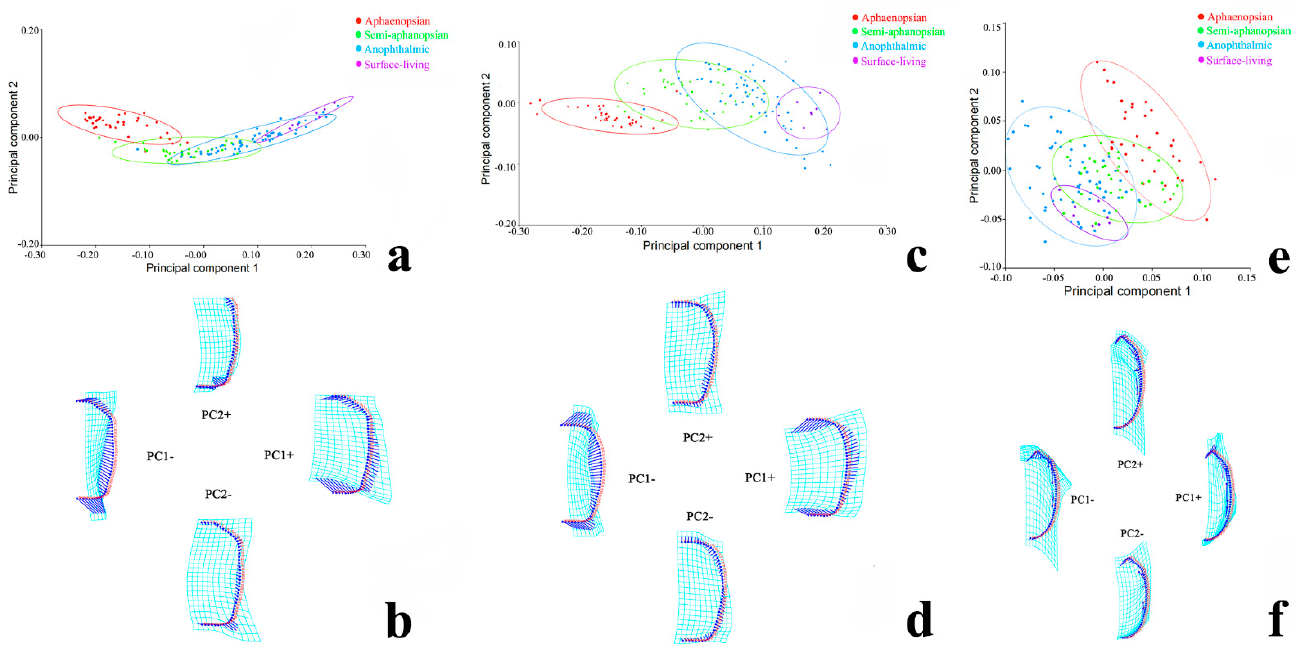
Figure 3. Principal component analysis (PCA) of four different adaptive types of ground beetles: ( a ) and ( b ) head; ( c ) and ( d ) pronotum; ( e ) and ( f ) elytra. ( a ), ( c ), and ( e ) represent scatterplot; ( b ), ( d ), and ( f ) represent the energy map.